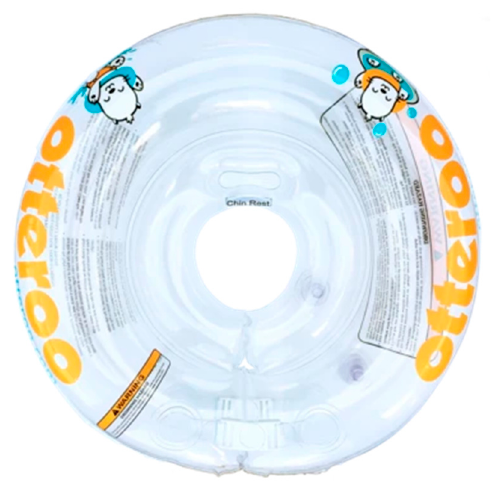
Figure A1. Photograph of the Otteroo LUMI Image from the Otteroo Corporation [19].